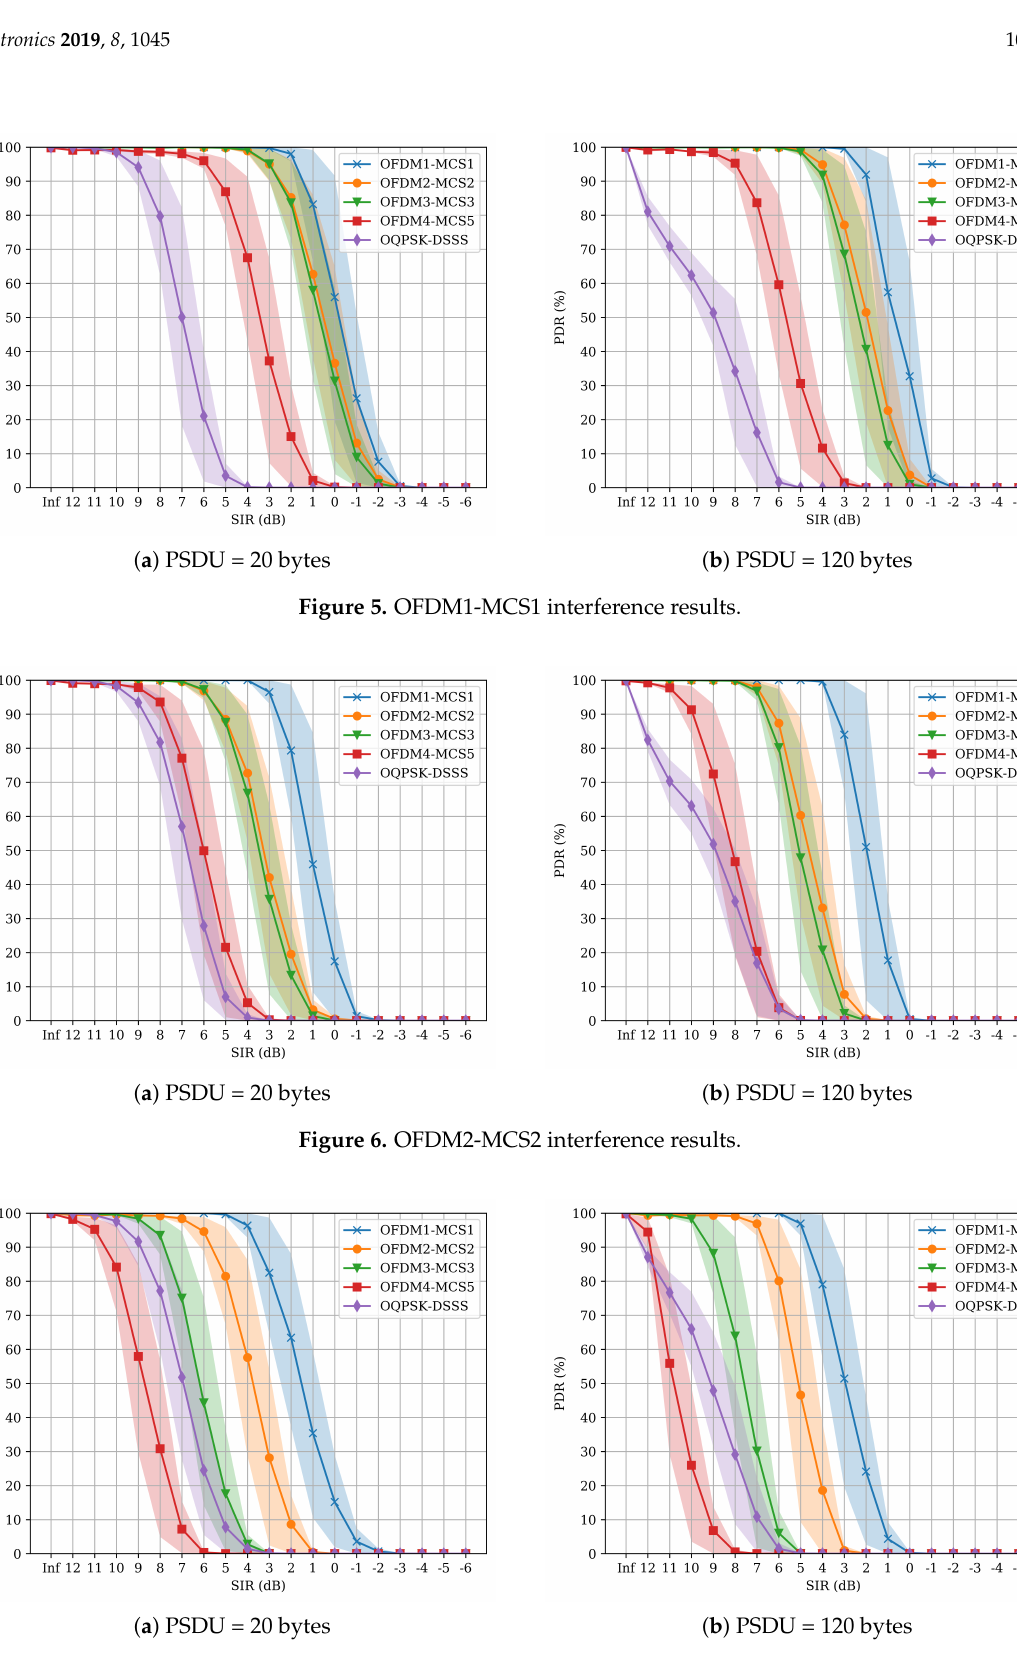
Figure 7. OFDM3-MCS3 interference